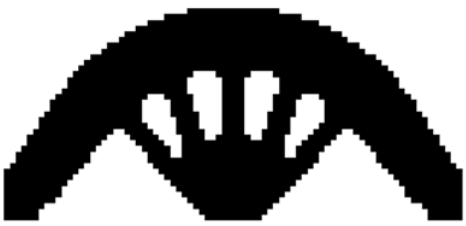
Figure 7. Optimized shape of simple bridge beam by the improved method.